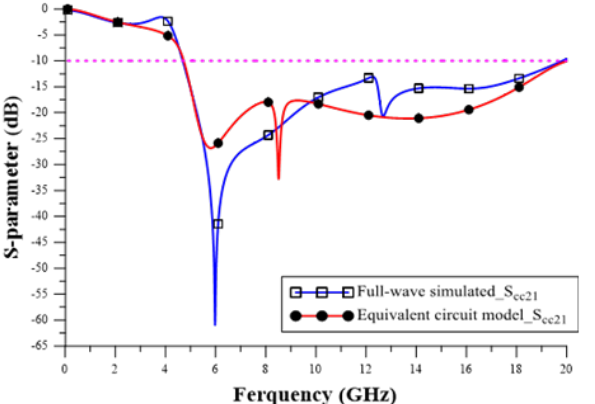
Figure 6. Verification equivalent half-circuit model by full-wave simulation of the CM insertion loss.